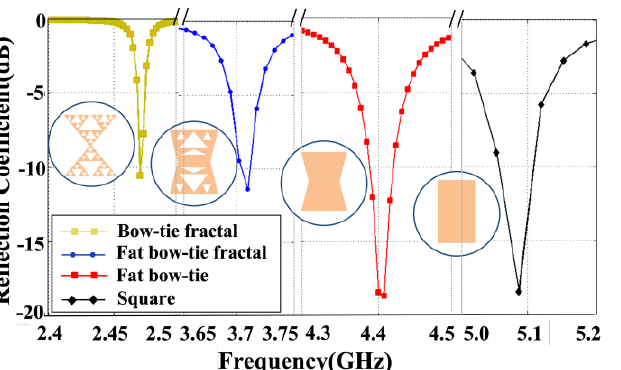
Figure 6. Reflection coefficients of different element antennas: bow tie fractal patch antenna, fat bow tie fractal antenna, fat bow tie antenna, and square patch antenna.